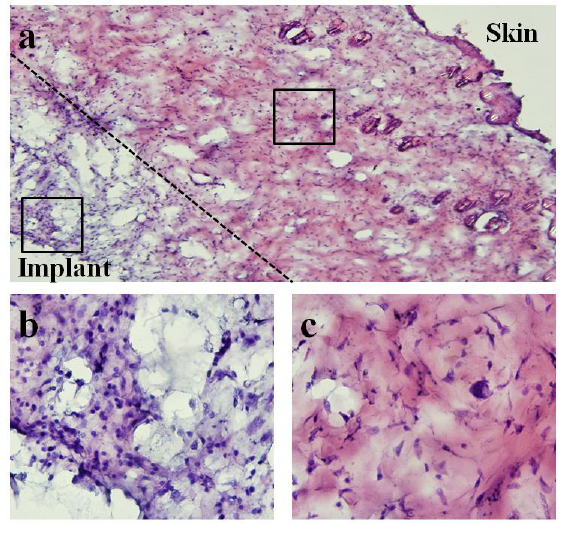
Figure 15. Light microscope images of hematoxylin and eosin (H&E)-staining of surrounding tissue capsule from 28-day implanted pressure sensor. Note that for histological examination purposes, the soft tissue capsule was removed from the pressure sensor prior to embedding and sectioning. ( a ) 10× image of both skin and implant sides of surrounding tissue capsule. ( b , c ) 60× images of implant and skin sides